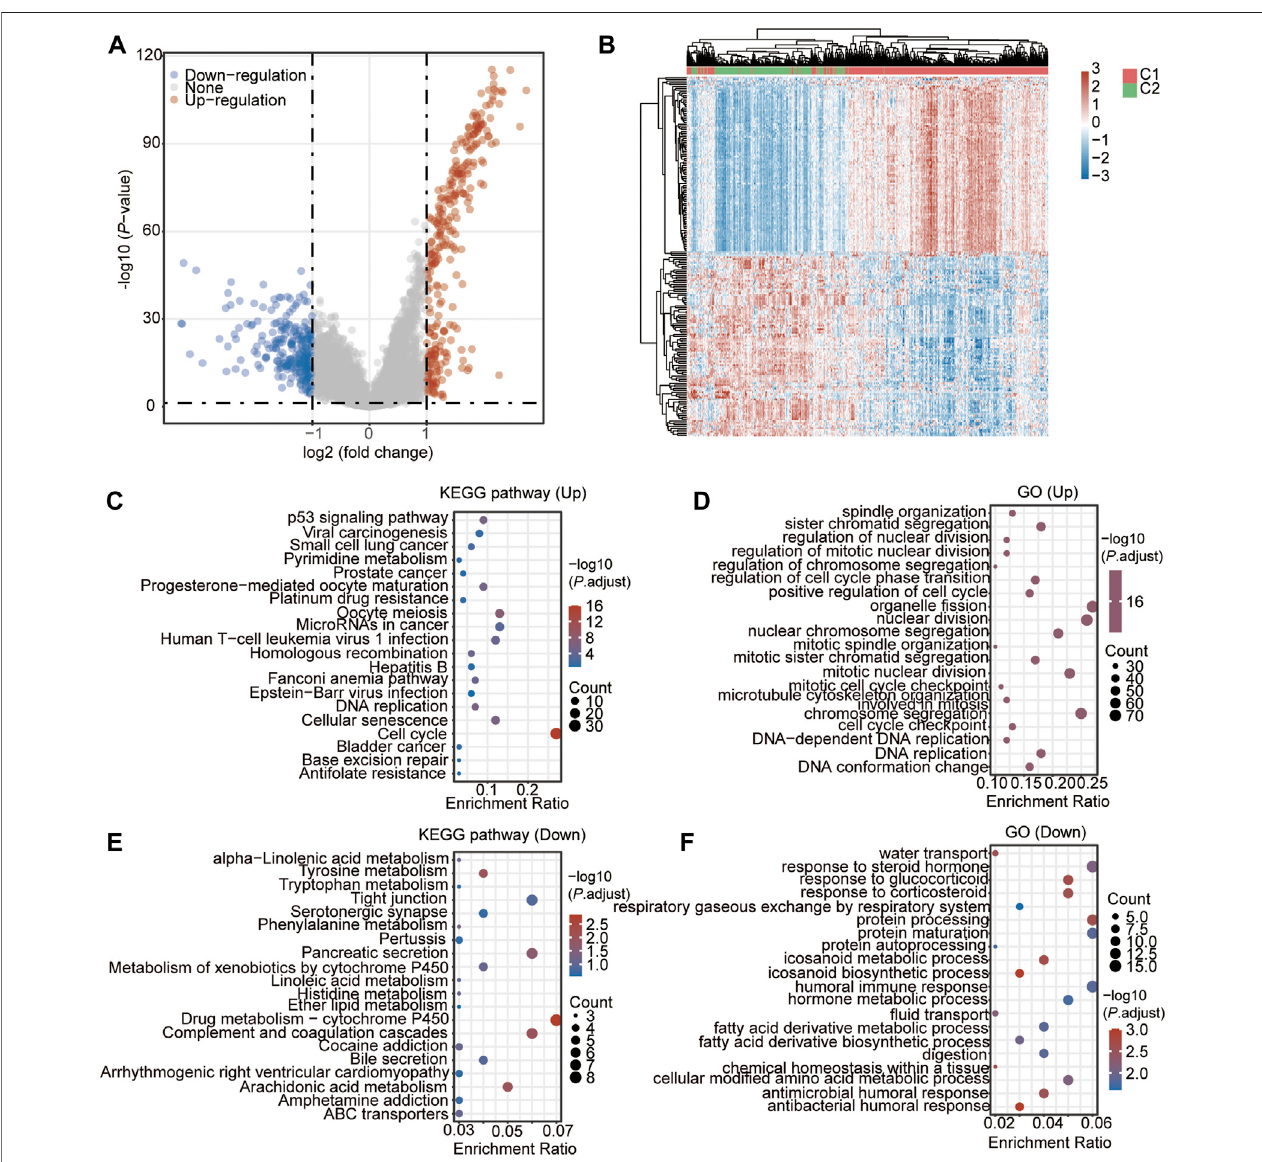
FIGURE 6 | DEGs and the functional analysis between the two CSRs-related clusters. (A) Volcano Plot showing the DEGs in cluster 1 vs. cluster 2. (B) Heatmap showing the DEGs in cluster 1 vs. cluster 2. (C) KEGG enrichment of up-regulated genes in cluster 1. D GO enrichment of up-regulated genes in cluster 1. (E) KEGG enrichment of down-regulated genes in cluster 1. (F) GO enrichment of down-regulated genes in cluster 1.